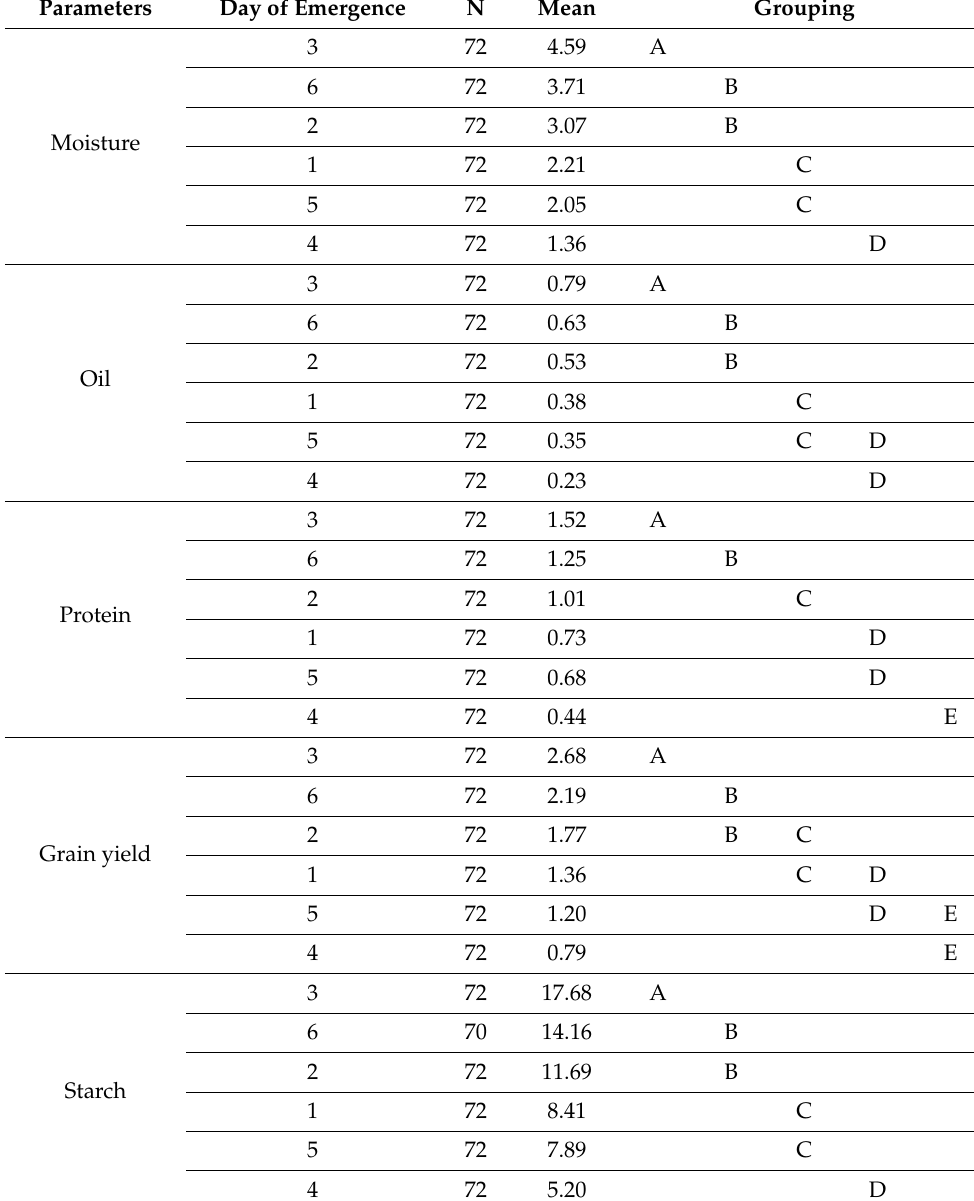
Table 3. Tukey grouping based on day of